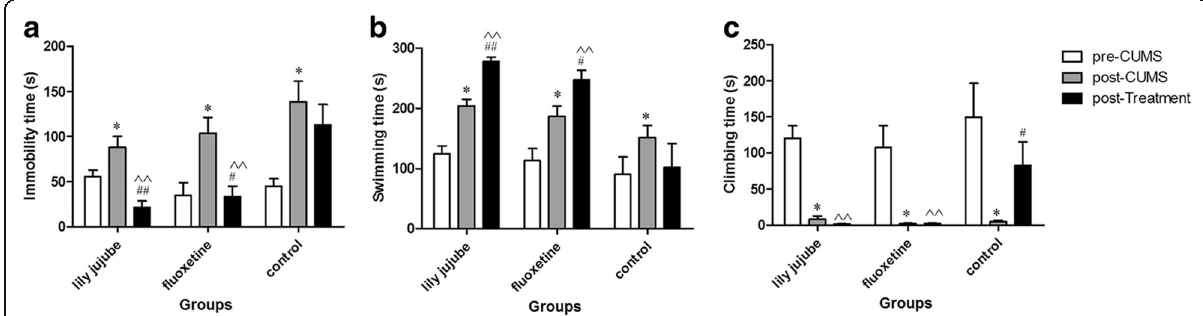
Fig. 3 Changes of immobility time, swimming time and climbing time in FST at different time points. a : Immobility time of FST; b : Swimming time of FST; c : Climbing time of FST. Note: *< 0.05 compared within group with pre-CUMS; # < 0.05 compared within group with post-CUMS; ## < 0.01 compared within group with post-CUMS; ^^<0.01 compared with the control